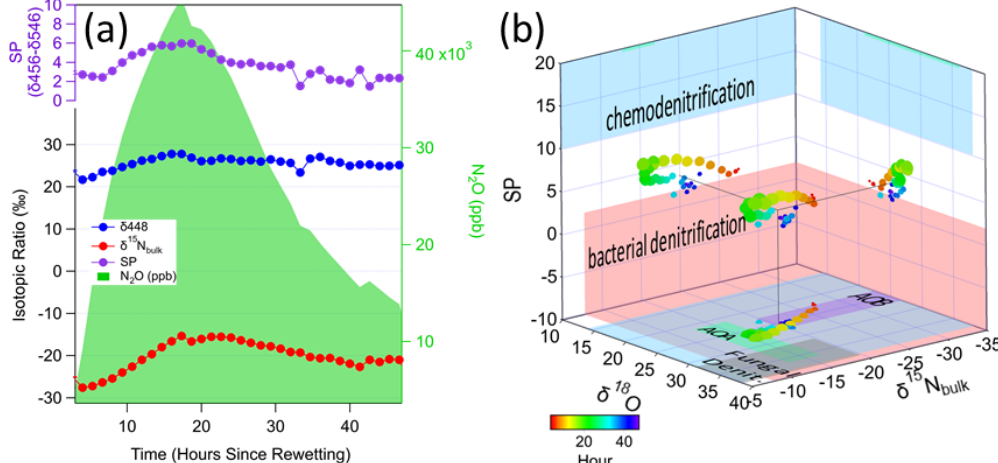
Figure 12. (a) Soil wetting induced a pulsed response in soil N 2 O (shaded green) and its isotopic signals including δ 448 (blue), δ 15 N bulk (red), and site preference (purple). A soil column without a lid was wetted with the equivalent of 5.1cm of rainfall. At 18h after wetting the dilution was changed from 2 : 1 to 3 . 8 : 1, and at 41h it was changed to 2 . 1 : 1, which is accounted for in the concentrations reported here. (b) Estimated map of N 2 O isotopic signatures of δ 15 N bulk ( x axis), δ 18 O ( y axis), and site preference ( z axis); circles represent probe measurements of the changes in the isotopic signatures with time (hours), indicating shifts into regions of different microbial activity (colored rectangles) (Table S3). On the x axis AOA (green rectangle) and AOB (purple rectangle) refer to nitrification from ammonia-oxidizing archaea and ammonia-oxidizing bacteria, respectively. The grey rectangle indicates fungal